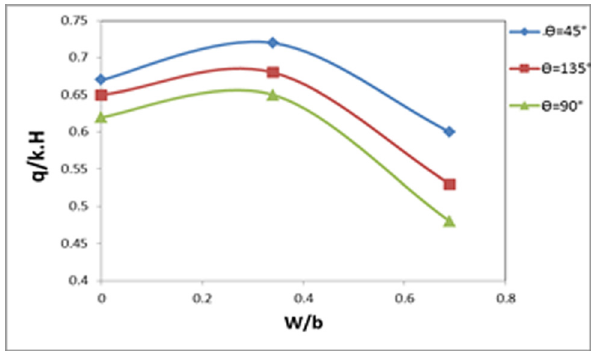
Figure 8: E ff ect of void width on leakage for cuto ff